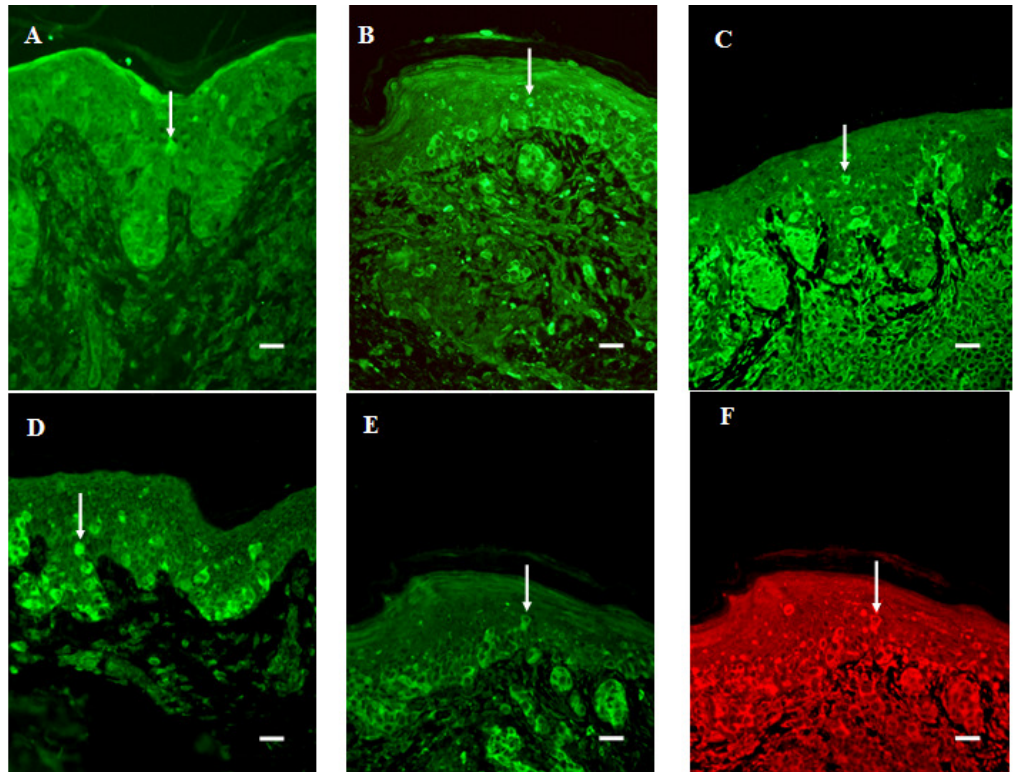
Figure 1. Melanoma cells in the suprabasal epidermis of SSM tissue that immunostain positively for 5-HT (arrow in A), 5-HT1AR (arrow in B), 5-HT2AR (arrow in C), or SERT (arrow in D). (B) Decreased junctional expression of 5-HT1AR in this same tissue. Double staining for 5-HT1AR (arrow in E, FITC) and 5-HT2AR (arrow in F, Texas Red). Bar is 20 µ m.